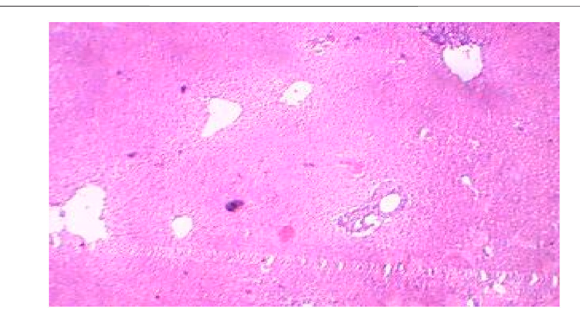
FIGURE 4 | Control liver showing preserved architecture.